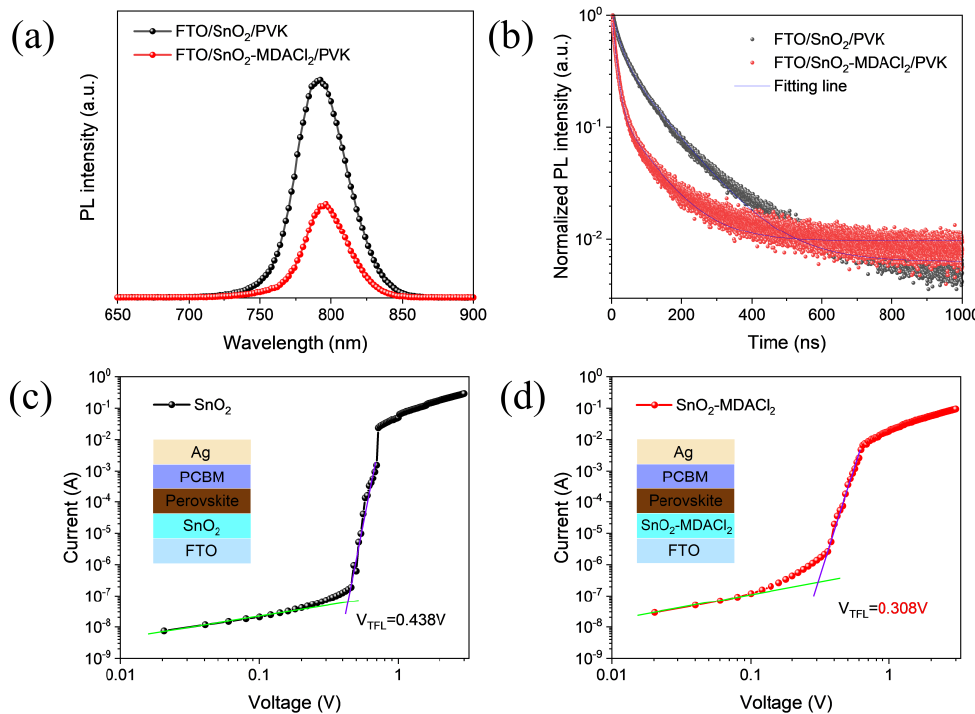
Figure 4. ( a , b ) Steady-state photoluminescence (SSPL) and time-resolved photoluminescence (TRPL) spectra of perovskite films deposited on the SnO 2 and SnO 2 -MDACl 2 ETLs. ( c , d ) Dark I–V curves of the electron-only devices. Insets show the schematic device structures.